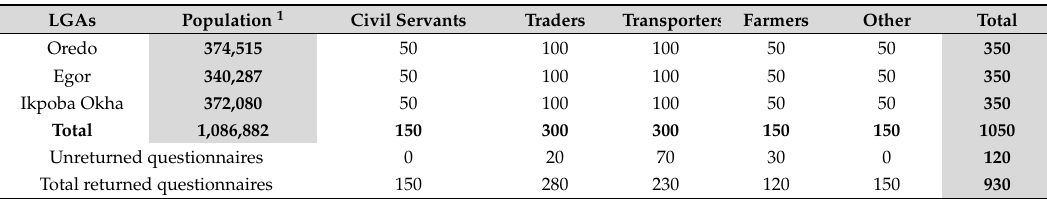
Table 1. Population of the study area as well as respondents’ distribution according to occupation and response analysis from the surveyed field